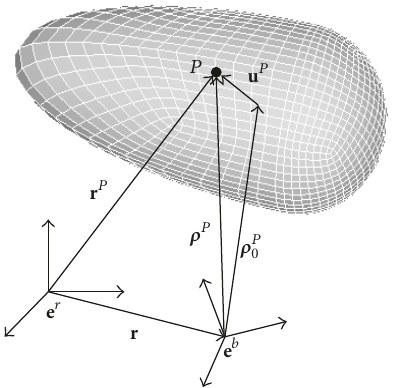
Figure 1: Kinematics of a single flexible